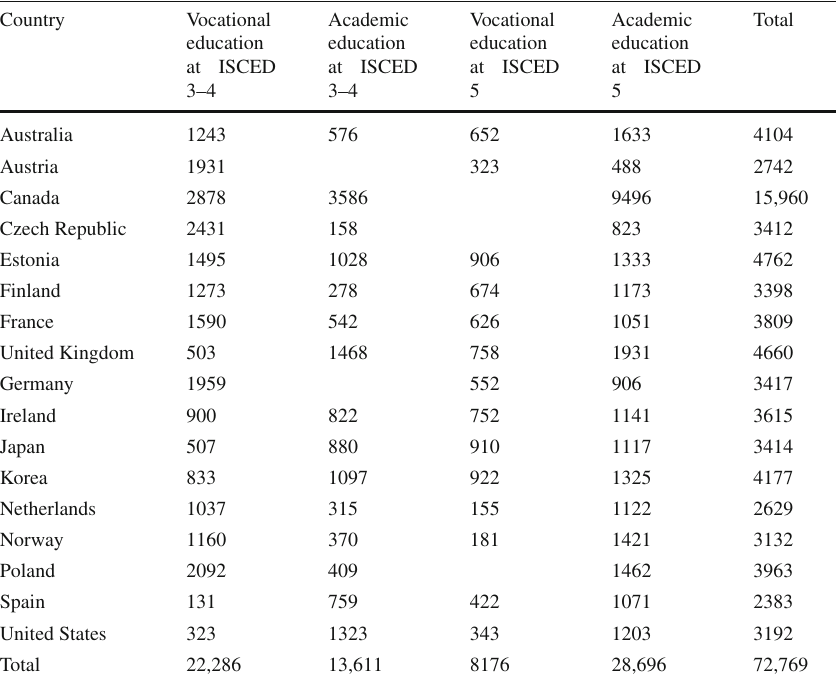
Table 1 The sample used in this study. Number of individuals. Source : PIAAC data